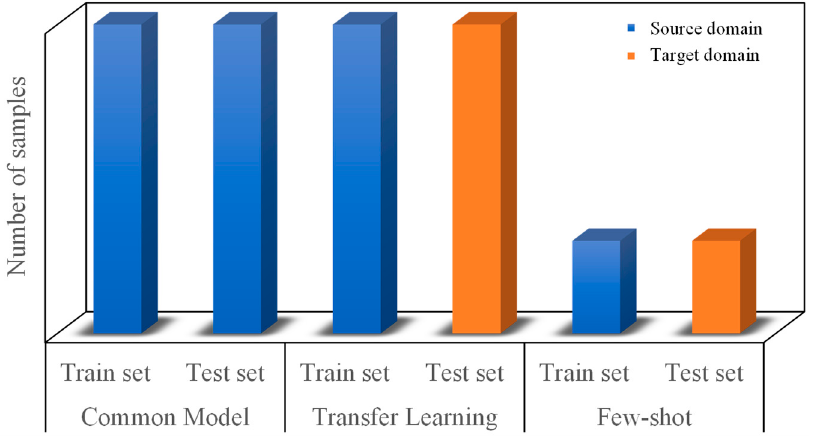
Figure 1. Three scenarios of intelligent fault diagnosis.